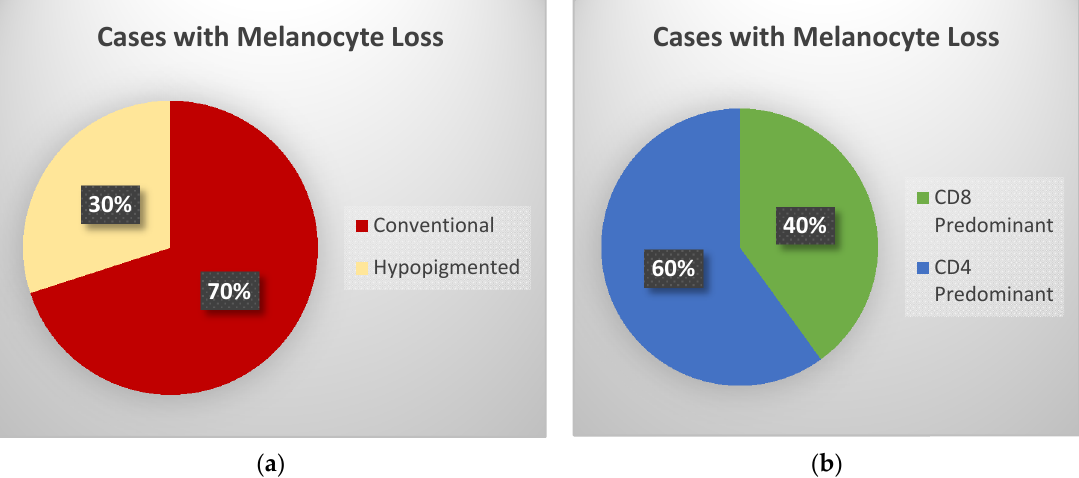
Figure 3. Ten cases displayed melanocyte loss by SOX10 IHC. The loss was observed in both conventional and hypopig- mented cases ( a ) and in CD8 or CD4 predominant cases ( b ).